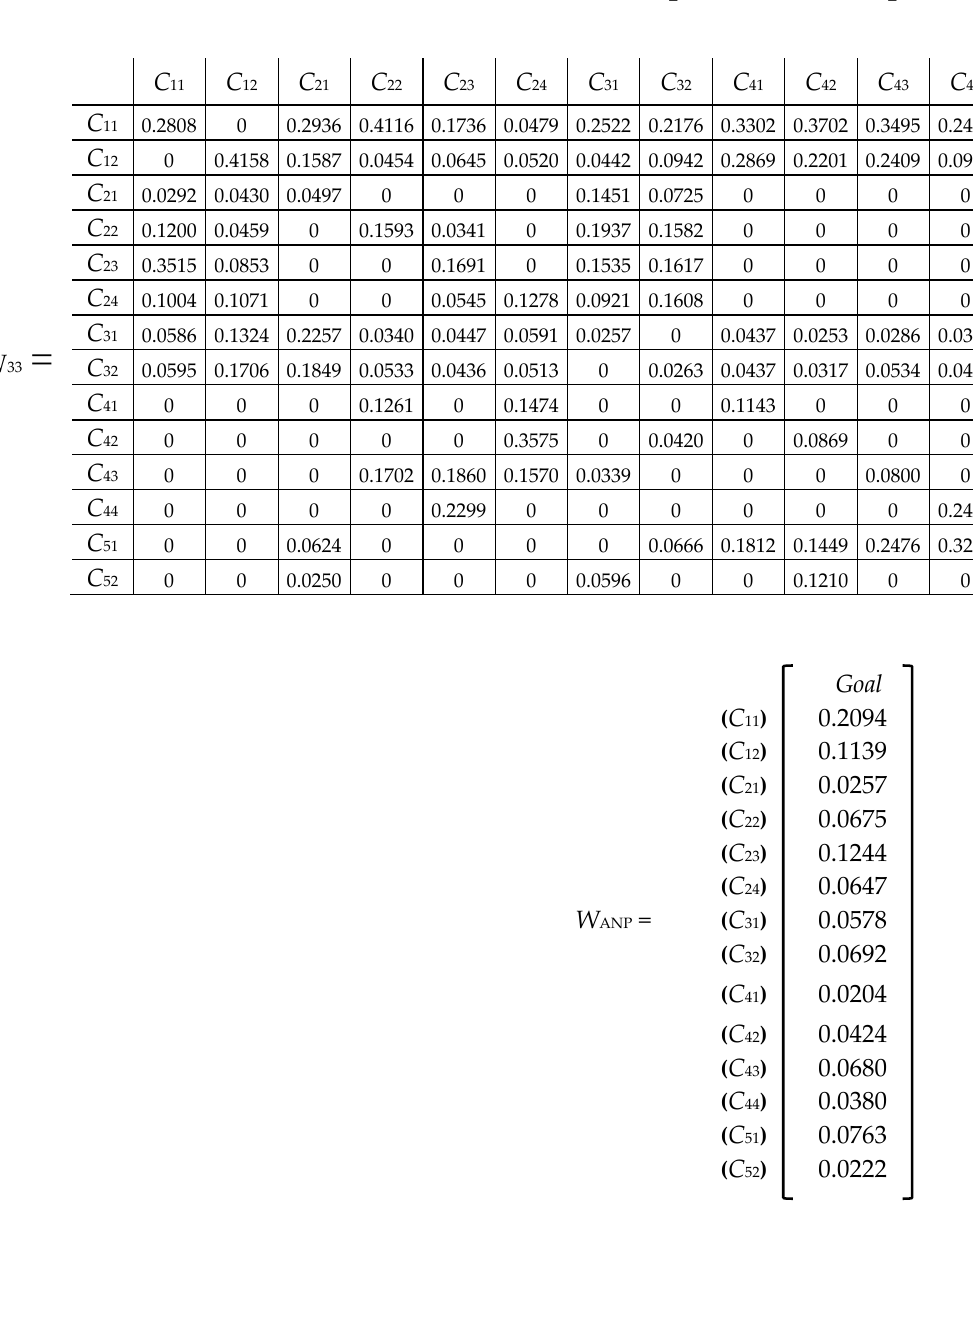
Table 11. Weights of the five alternatives calculated using the pairwise comparison matrix for subcriterion C 12 . ( C 12 )